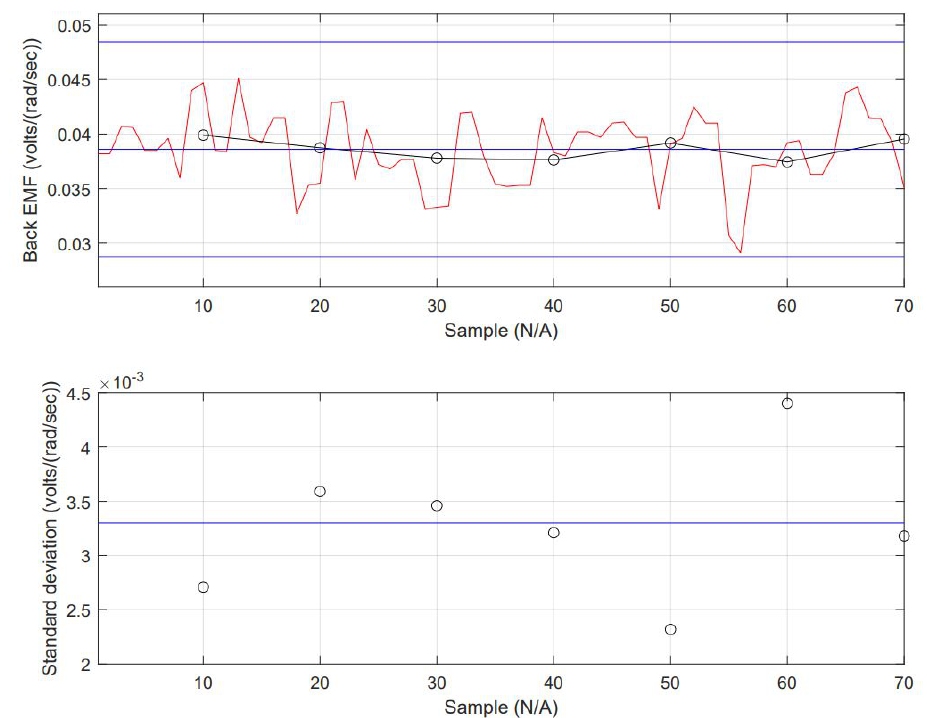
Figure 9. Mean and Standard deviation chart of simulated Back EMF data. The data is displayed in 10 sets of 7 elements